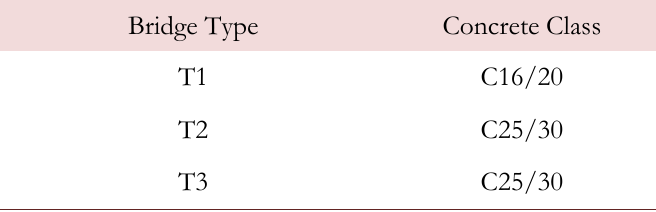
Table 5: Concrete class for each bridge